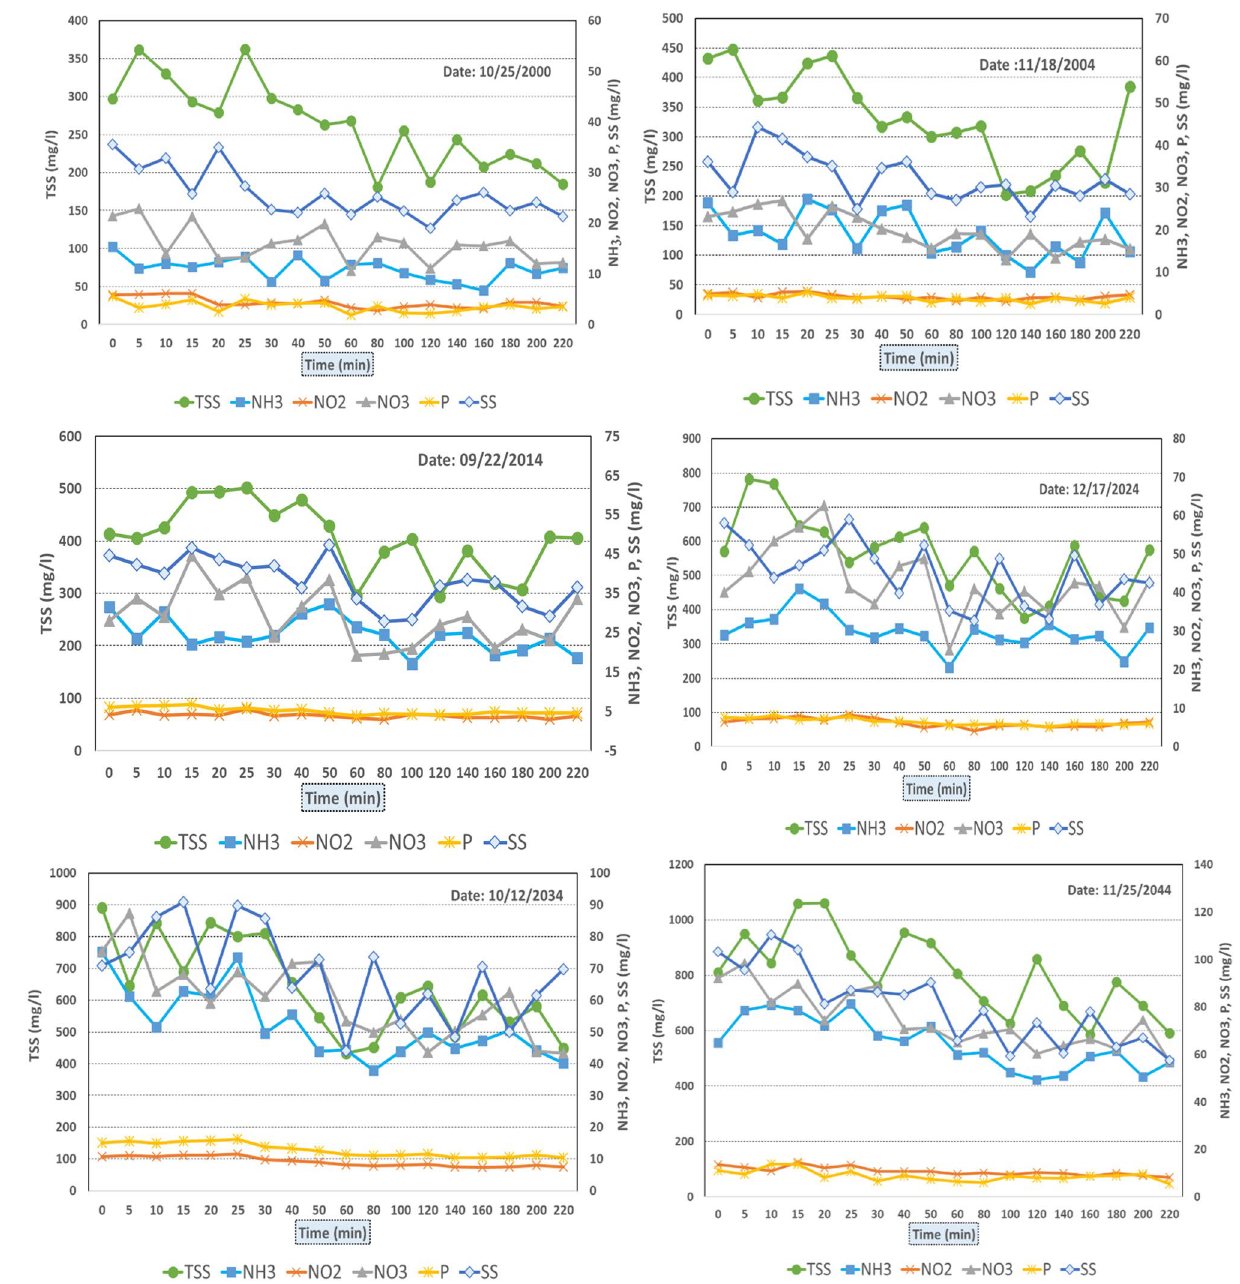
Figure 11. Simulated pollution runoff under climate change.